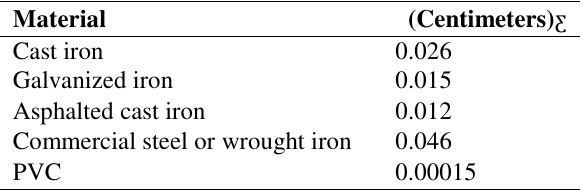
Pipe internal Roughness